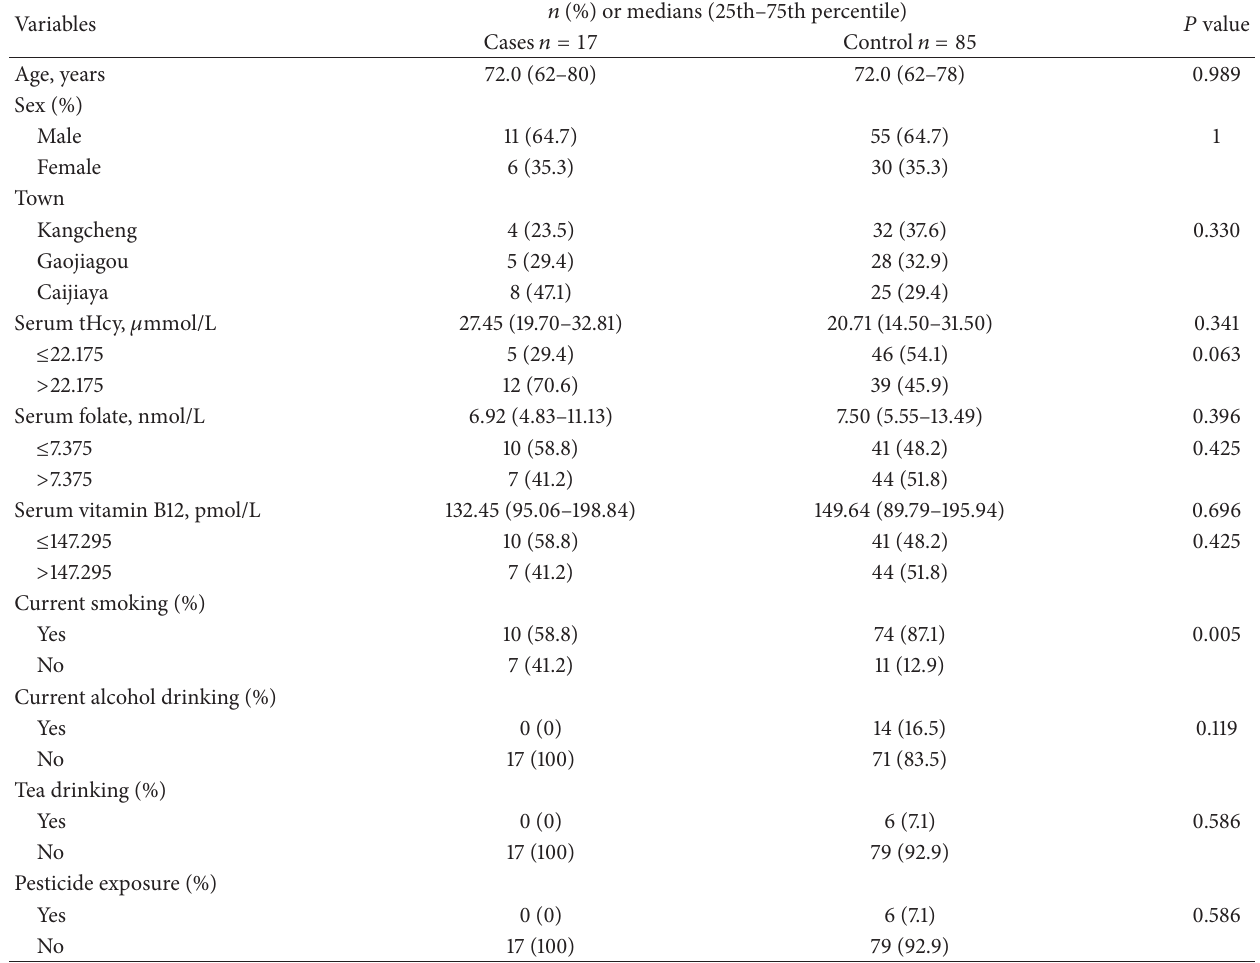
Table 3: General characteristics of cases and controls.